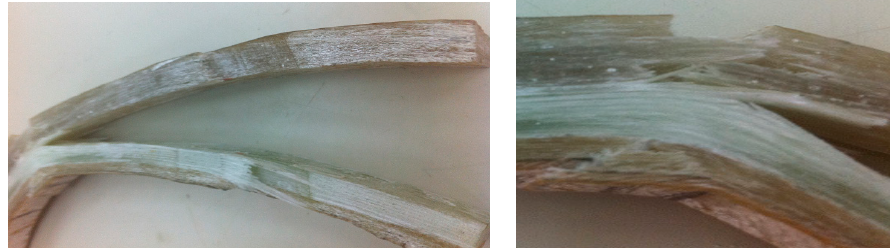
Figure 11. A severe delamination between the composite overwrapped and the joined straight pipes sections.